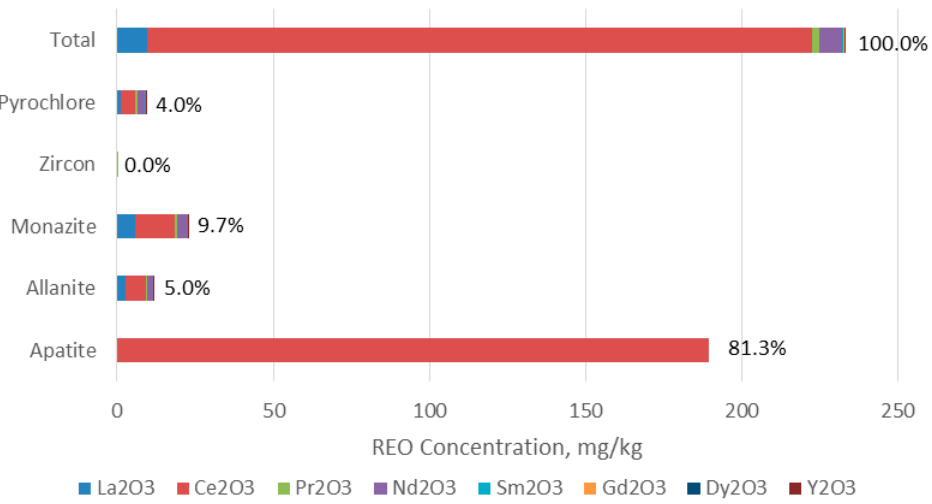
Figure 2. Rare Earth oxide (REO) concentrations in the REE-bearing phases of the ore (mg/kg).